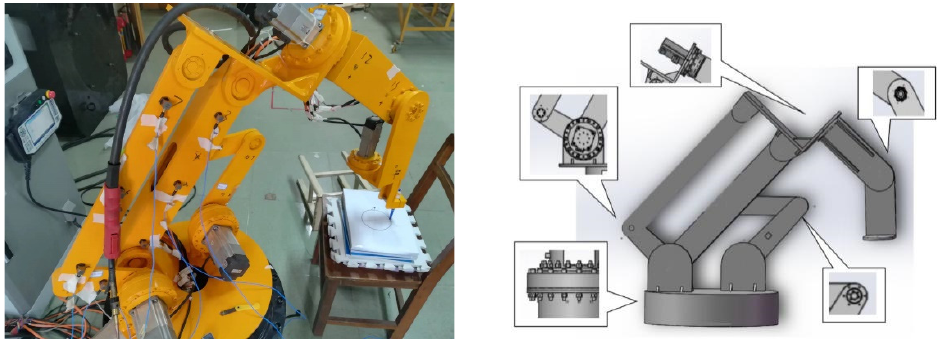
Figure 1. The prototype and model of the controllable mechanism welding robot.